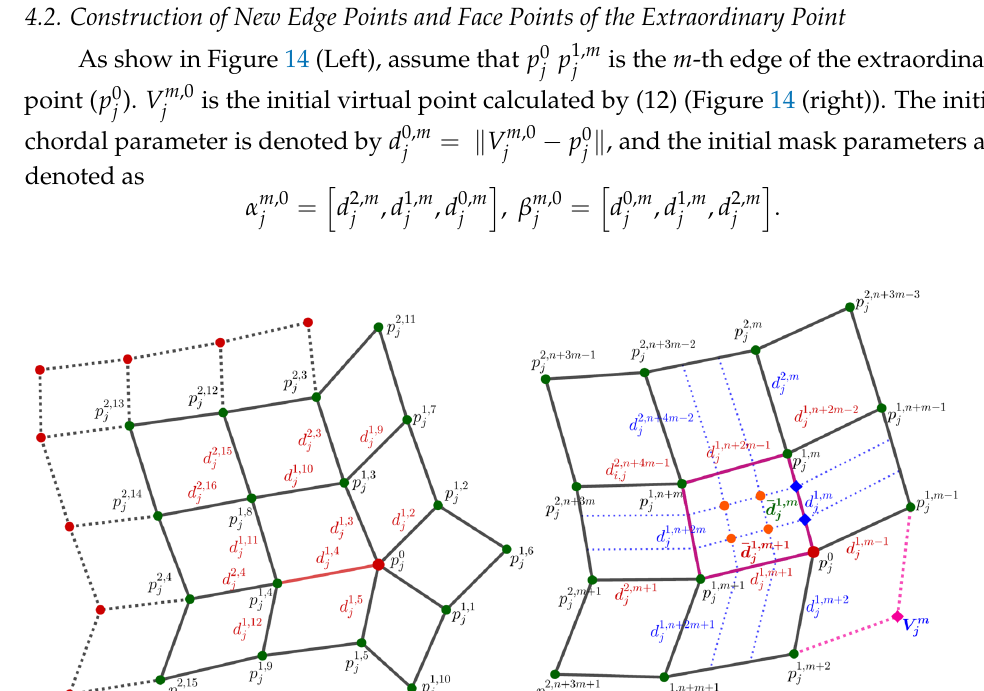
Figure 14. Notations for the construction of new edge points and face points at the extraordinary point. Left: an initial control mesh, where p 0 is the extraordinary point. Right: By generating virtual j point V m , irregular quadrilateral mesh is transformed into regular j